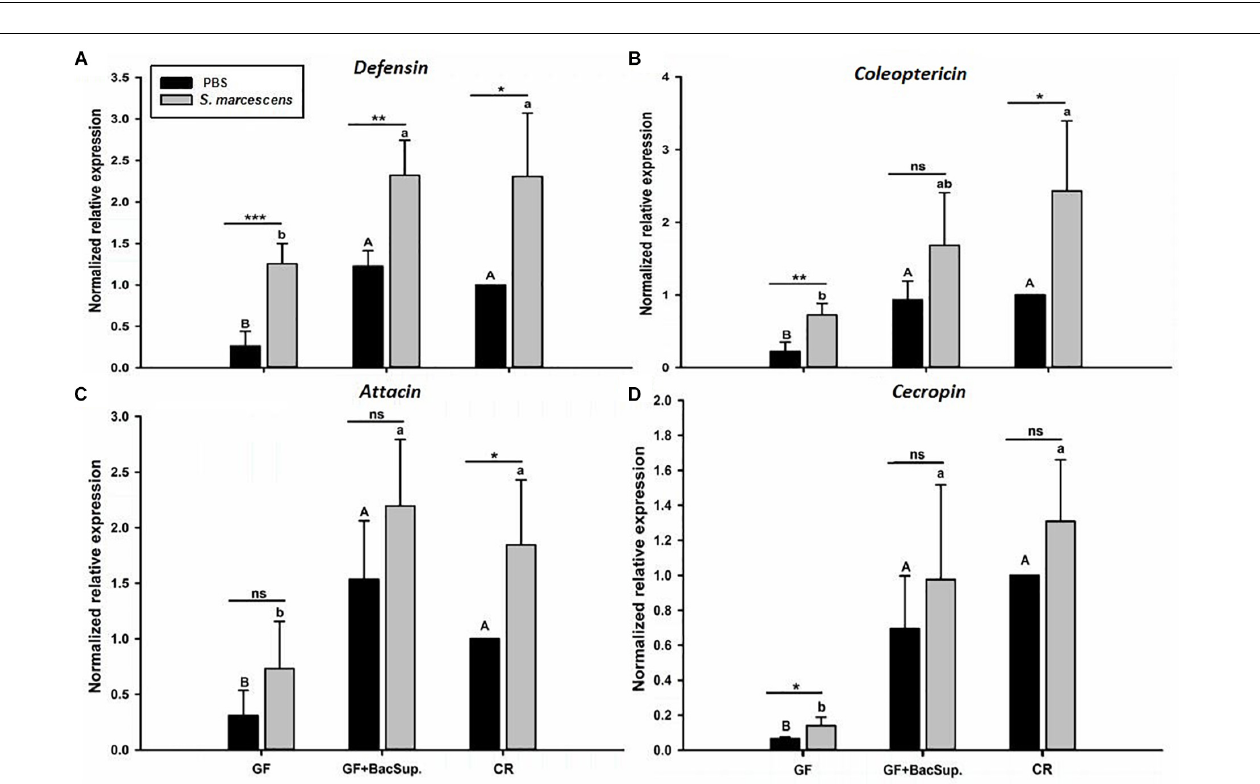
FIGURE 8 | The effect of bacterial challenge on the expression level of Relish in the fat body of symbiotic (GF BacSup and CR) and aposymbiotic (GF) RPW larvae. Uppercase and lowercase letters indicate the statistical differences across control and bacteria challenge groups, respectively. “ ∗ ” presents the significance within each cohort ( t -test: ∗ P < 0.05, ∗∗ P < 0.01). Error bars represent the standard deviation of four independent replicates.